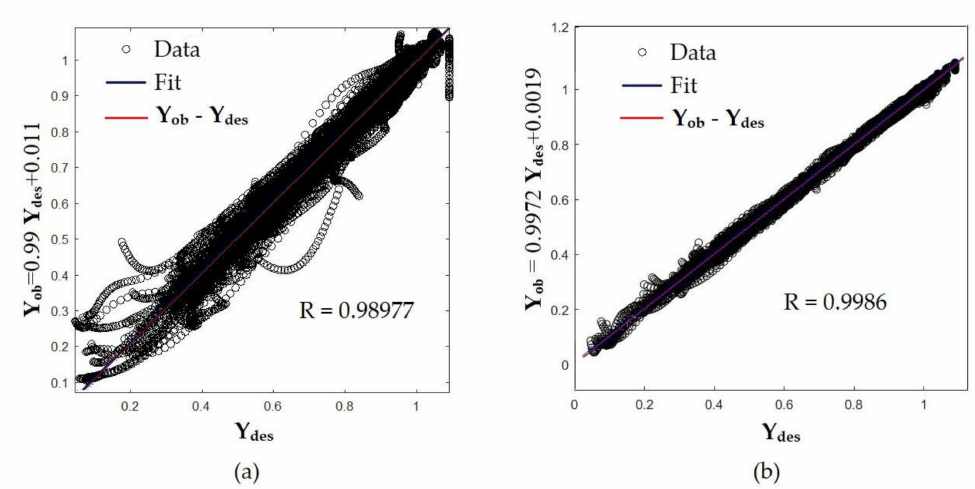
Figure 5. Correlation analysis between the variables: desired output ( Y des ) and obtained output ( Y ob ) in training, validation, and test; ( a ) MLP, ( b ) RBF.